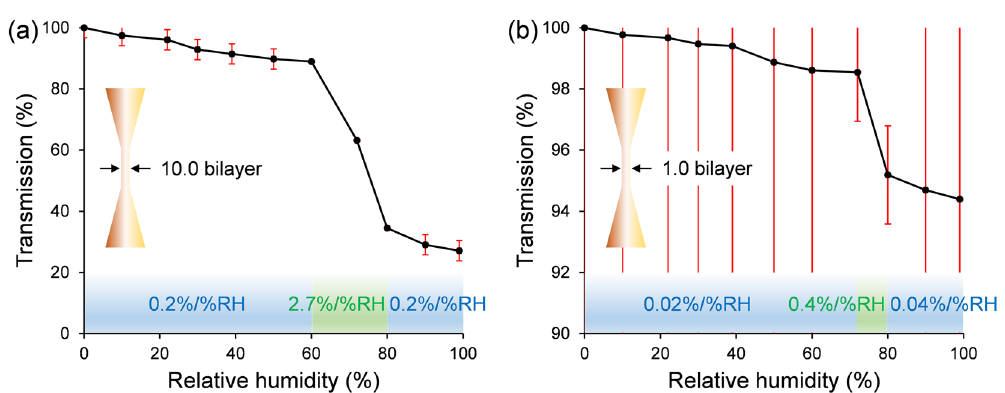
Figure 4. Optical transmission as a function of RH for: ( a ) 10.0 bilayer, and ( b ) 1.0 bilayer